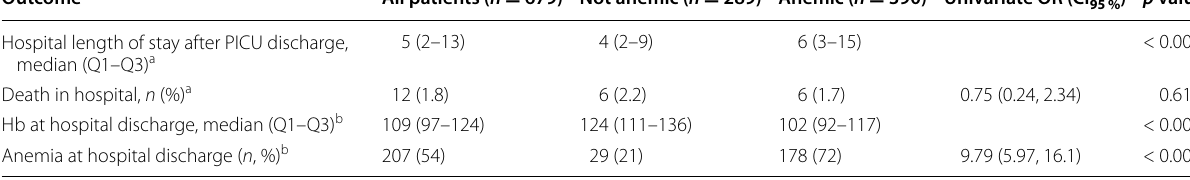
Continuous variables are expressed as median (interquartile range) OR odds ratio, Hb hemoglobin, CI confidence interval a For children discharged alive from PICU b Available for 386 children